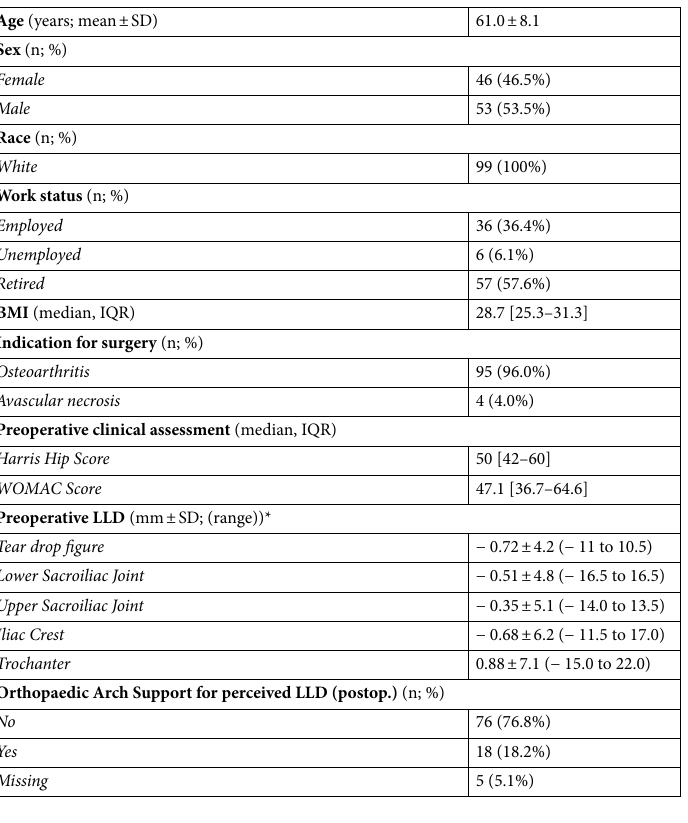
Table 1. Patient demographics (n = 99). BMI body mass index, LLD leg length difference, IQR interquartile range, WOMAC Western Ontario and McMaster Universities Osteoarthritis Index. *Mean of the two observer’s measurements.